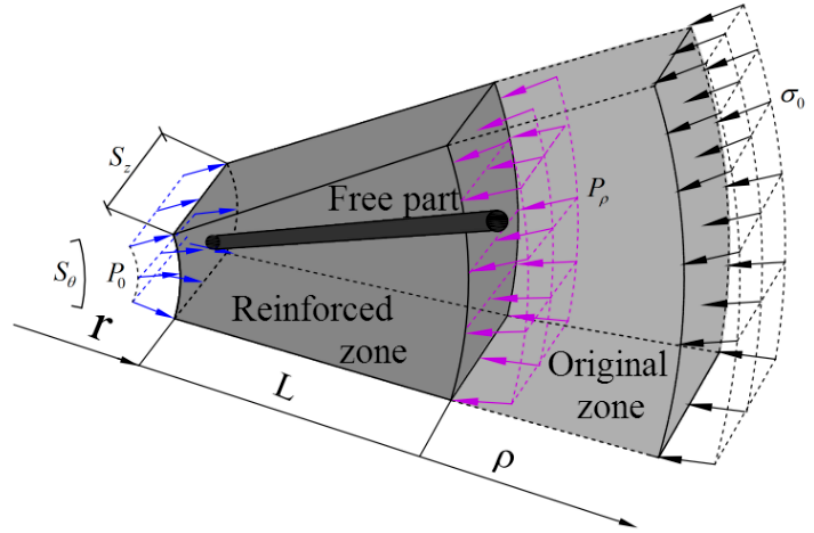
Figure 2. Internal structure of the interaction model.